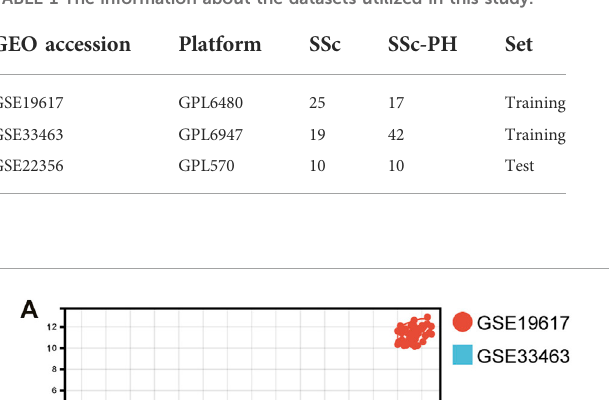
TABLE 1 The information about the datasets utilized in this study.